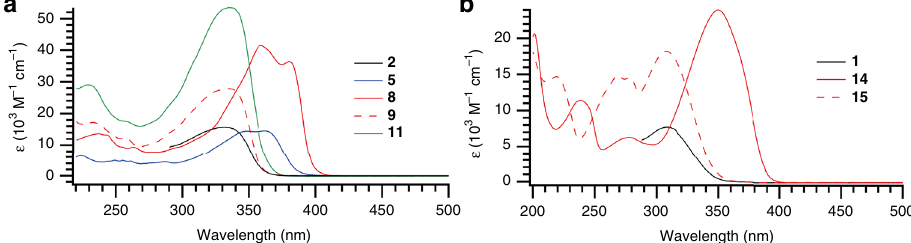
Fig. 5 Optical absorption spectra. a UV − Vis absorption spectra of acetylene-linked norbornadienes. Black line: 2 , blue line: 5 , red line: 8 , red dashed line : 9 , green line: 11 . b UV − Vis absorption spectra of phenylene-linked norbornadienes. Black line: 1 , red line: 14 , red dashed line: 15 . The spectra of monomers 1 and 2 were recorded in toluene